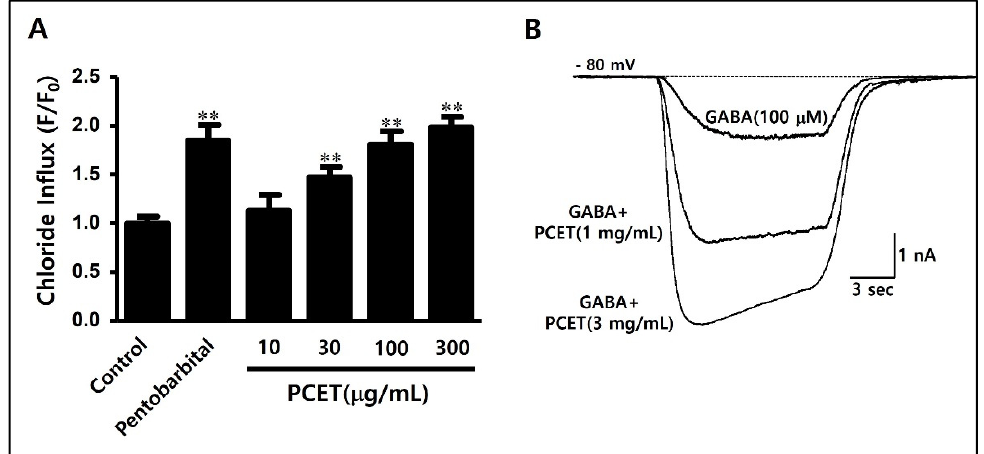
Figure 5. Cl − influx and GABA-induced Cl − current-enhancing effects of PCET in superior cervical ganglion cells. ( A ) After 12 h of exposure to MQAE, Cl − selective fluorescence dye, superior cervical ganglion cells were filtrated at 380 nm in a FlexStation 3 reader and measured wavelengths emitted at 460 nm. Pentobarbital (10 µ M) was used as a positive control, and the negative control was measured with no processing. PCET was administered 1 h before measurement, at a concentration range of 10–300 µ g/mL. The data are shown as mean ± standard deviation. Experiments were repeated 10 times. Statistical significance was evaluated using the p -value, and the difference from the negative control was marked as ** p < 0.001. PCET increased the Cl − inflow into cells concentration- dependently. ( B ) The GABA-induced Cl − current strengthening effect was verified by treating 1 mg/mL and 3 mg/mL PCET on the Cl − current induced using a 10 s GABA (100 µ M) treatment for a superior cervical ganglion cell fixed at − 80 mV. The Cl − current increased according to the PCET treatment